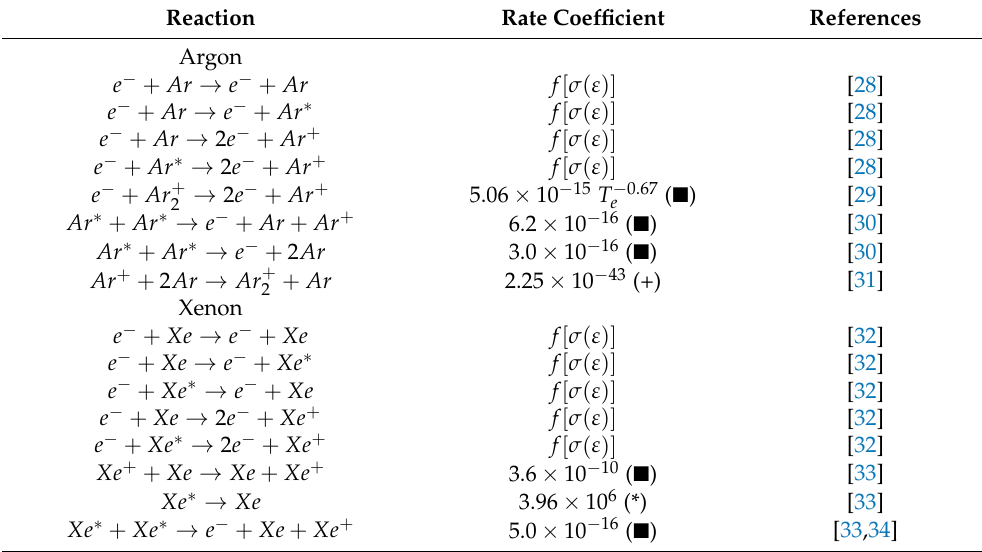
Table 1. Electron-impact and chemical reactions with rate coefficients for argon and xenon discharges. Reactions with a ( (cid:147) ) have units of m 3 /s; (+) in units of m 6 /s, and (*) in units of s − 1 . Reaction Rate